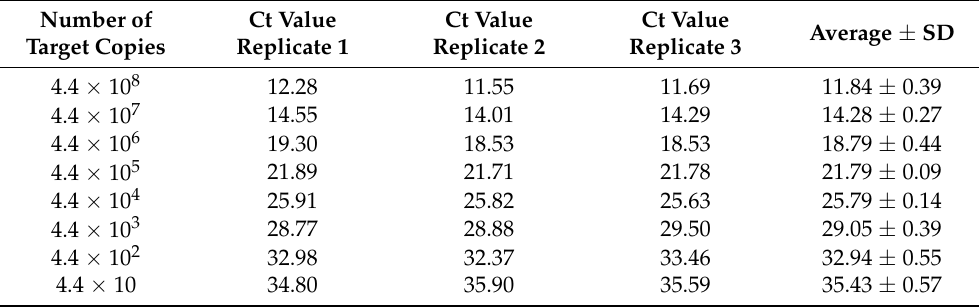
Table 2. GLRaV-1 real-time RT-PCR quantitation range. Ct values for different amounts of GLRaV-1 CP RNA transcripts are